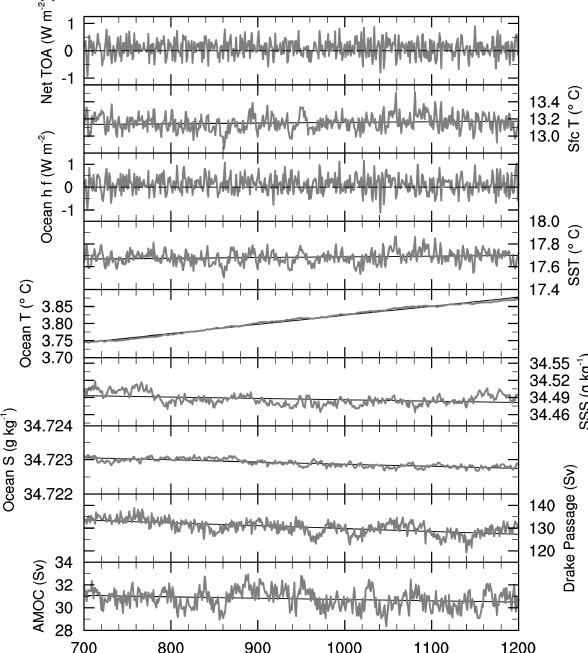
Fig. 2. Annual mean time series between year 700 and 1200 from piControl of, from top: Net radiation at TOA (Wm − 2 ) with positive values indicating warming of the atmosphere (mean value is +0.086Wm − 2 ); near surface air temperature ( ◦ C; mean value is 13.15 ◦ C); net heat flux into the ocean-sea (Wm − 2 , positive value means ocean warming, mean value is +0.122Wm − 2 ); sea surface temperature ( ◦ C, mean value is 17.68 ◦ C); volume average ocean temperature ( ◦ C, mean value is 3.81 ◦ C); sea surface salinity (g kg − 1 , mean value is 34.49 g kg − 1 ); volume averaged ocean salinity (g kg − 1 , mean value is 34.72 g kg − 1 ), net volume transport through the Drake Passage (Sv, mean value is 130 Sv), and the strength of AMOC at 26.5 ◦ N (Sv, mean value is 30.8 Sv). The black dashed lines in the two heat flux panels show the zero value, whereas the solid black lines in the other panels show the linear trends for year 700–1200.